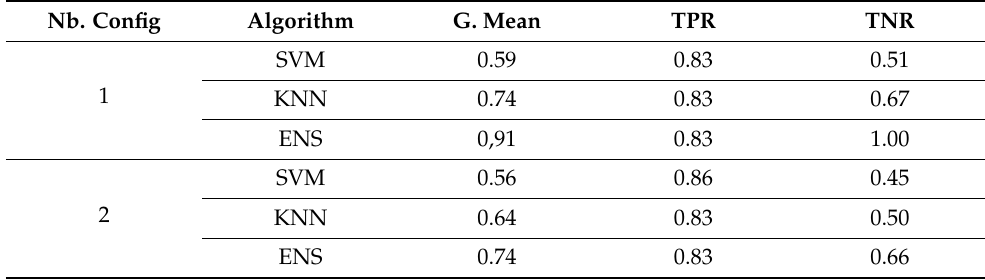
Table 8. Performance metrics for physiological configurations.